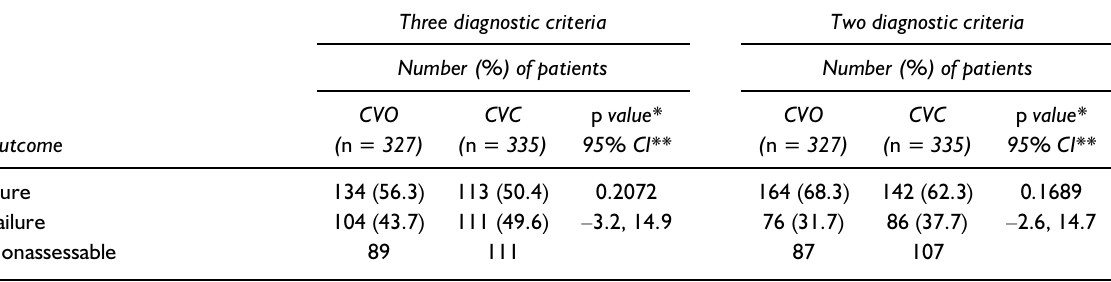
Table 3 Clinical outcome for ovule (CVO) and cream (CVC) groups using three and two diagnostic criteria for the intent to treat (ITT)